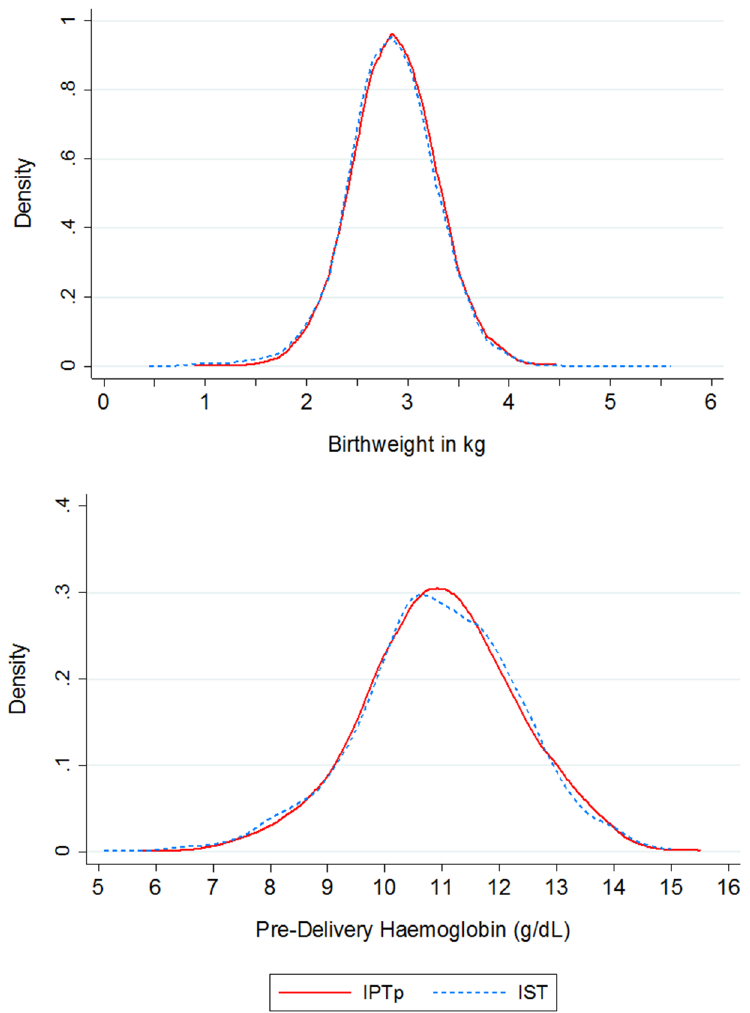
Fig 3. Distribution of birth weight (A) and hemoglobin concentration (B) at fourth ANC visit by intervention group. Birth weight distributions were estimated using data from 2183 women in the IPTp-SP group and from 2208 women in the ISTp-AL group. Hemoglobin distributions utilise data from 1534 women in the IPTp-SP group and from 1600 women in the ISTp-AL group.